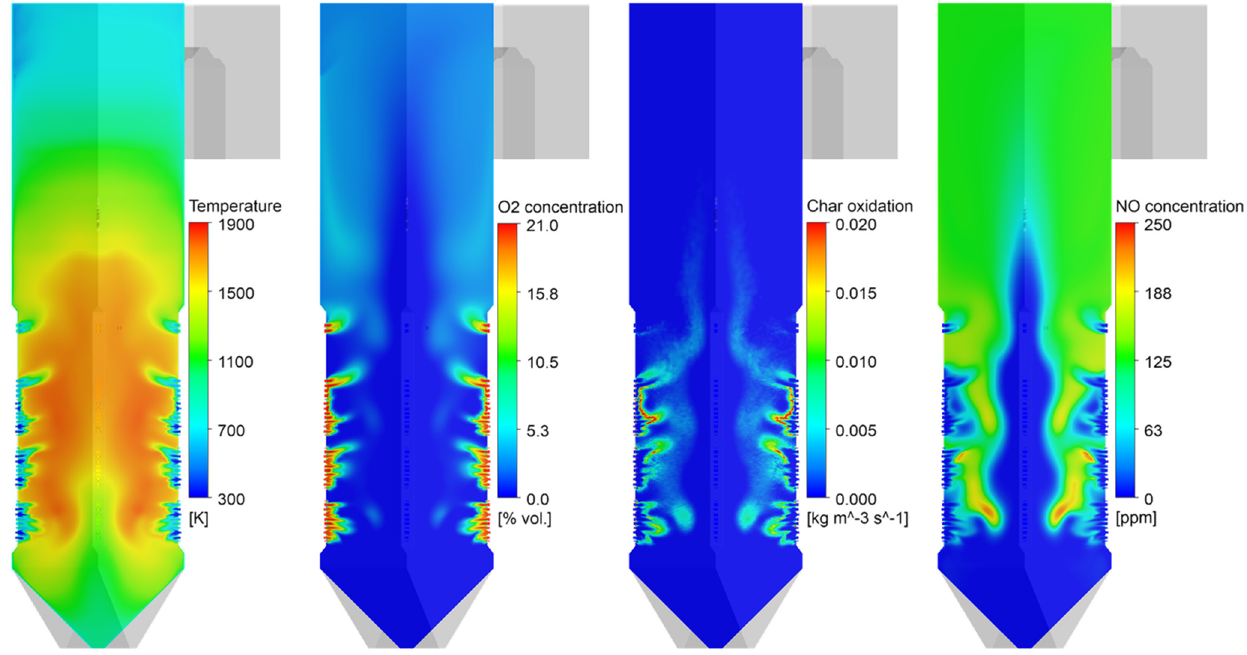
Figure 4. Contours of gas temperature, O 2 mole fraction, char burnout, and NO mole fraction in the boiler.